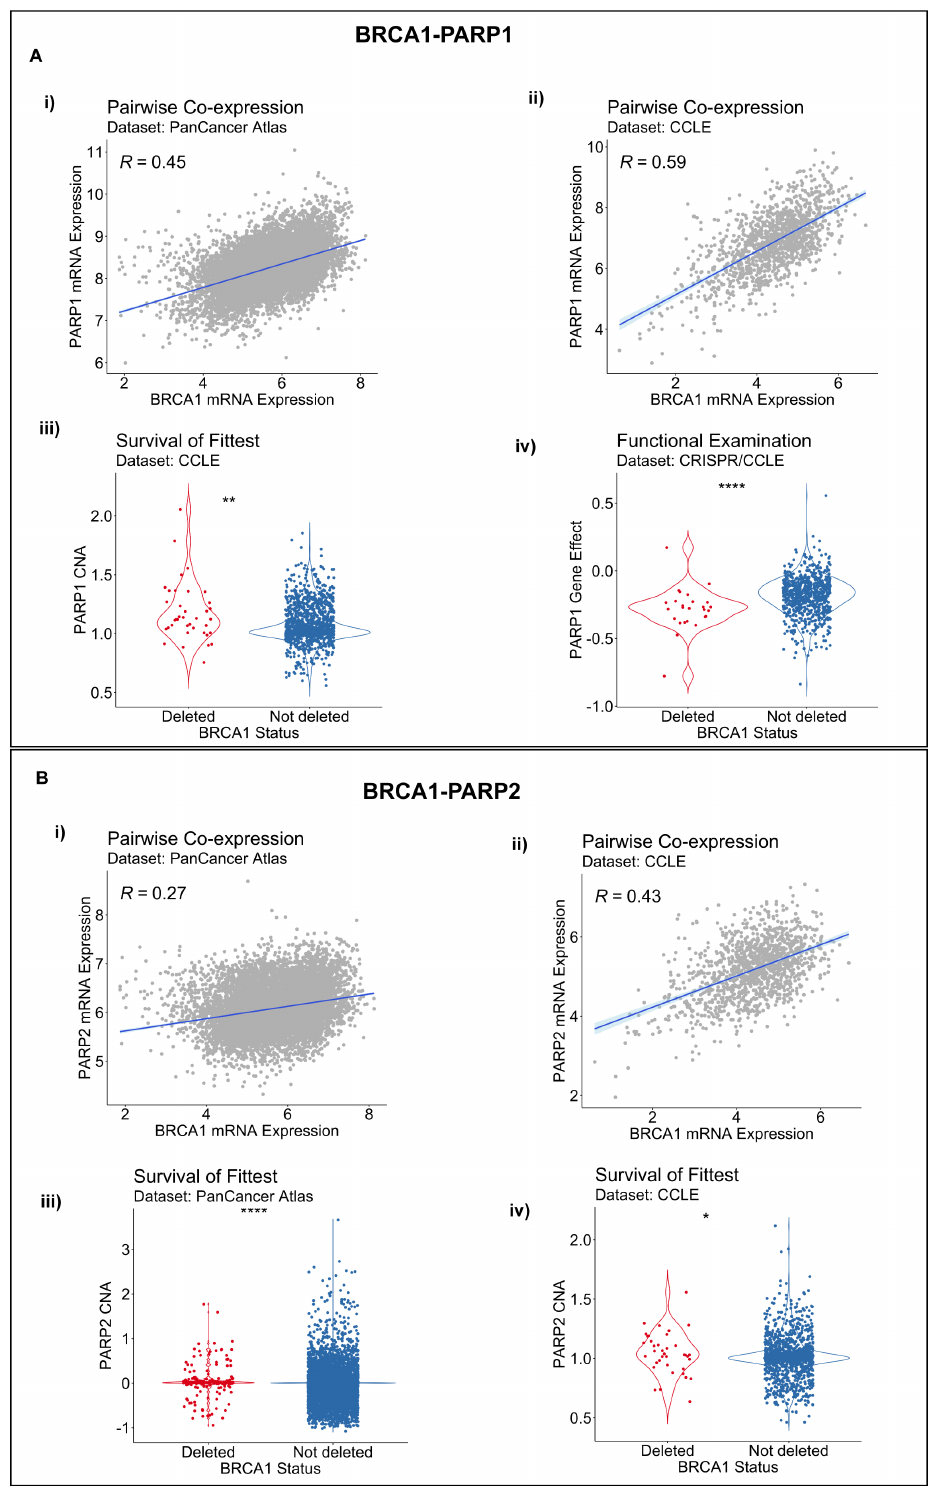
Figure 3. Evidence for BRCA1-PARP1/2 synthetic lethal relationship based on the DAta-minIng SYnthetic lethality identification (DAISY) workflow. A . Evidence for a BRCA1-PARP1 synthetic lethal relationship by pairwise co-expression in i) Pan- Cancer Atlas and ii) CCLE datasets respectively; iii) by survival of the fittest in in CCLE data; and iv) by functional examination in DepMap CRISPR. B . Evidence for a BRCA1-PARP2 SL relationship by pairwise co-expression in i) Pan-Cancer Atlas and ii) CCLE datasets and by survival of the fittest in iii) Pan-Cancer Atlas and iv) CCLE datasets. R, Spearman correlation coefficient; p, P value by the one-sided Wilcoxon rank-sum test; * P < 0.05; ** P <0.01; **** P <